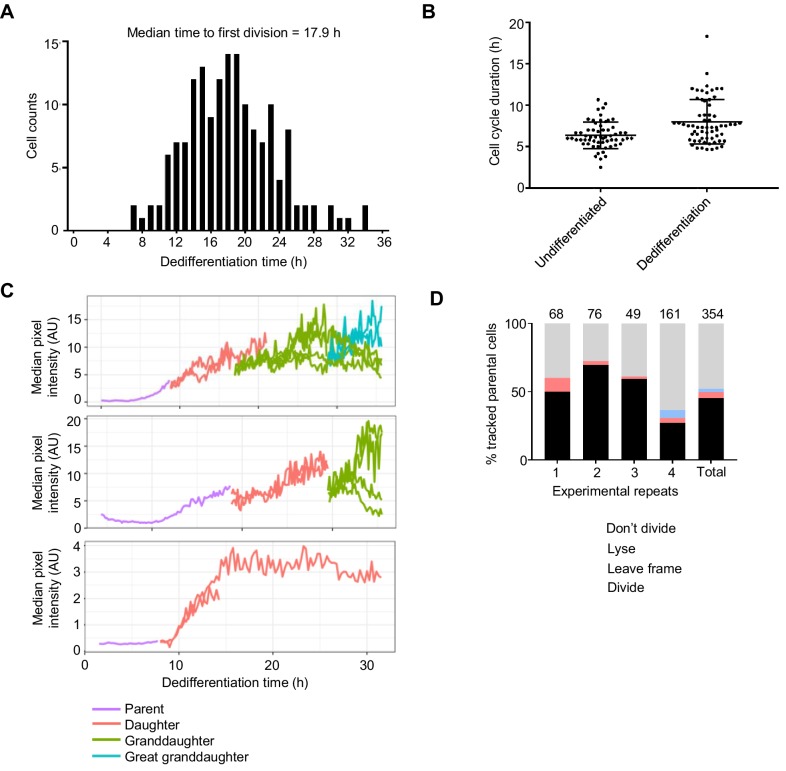
Timing of gene expression changes and cell division during dedifferentiation in single cells.(A) Distribution of times to first division (160 dividing cells pooled from four experiments). (B) Comparing cell cycle duration of dedifferentiating cells (n = 64, four replicates) with undifferentiated cells (n = 60, two replicates). The cell cycle duration plotted here is the first complete cycle after onset of dedifferentiation (the cycle after the first mitosis). Plot shows mean and SD. Mann-Whitney p=0.0005. (C) Examples of Act8 reporter expression in lineages of dedifferentiating cells. Onset of Act8 induction occurs before division in the majority of cases, but expression often continues to increase in daughter and granddaughter cells. In the bottom panel is an example of a cell dividing before the increase in Act8 reporter expression. (D) Summary statistics of single cell tracking for 354 dedifferentiating cells, with individual experiments and pooled data shown.Figure 4—figure supplement 1—source data 1.Act8 reporter intensity tracks, cell fate data, Act8 reporter induction measurements, and cell cycle duration measurements.Related to Figure 4B–F and Figure 4—figure supplement 1.